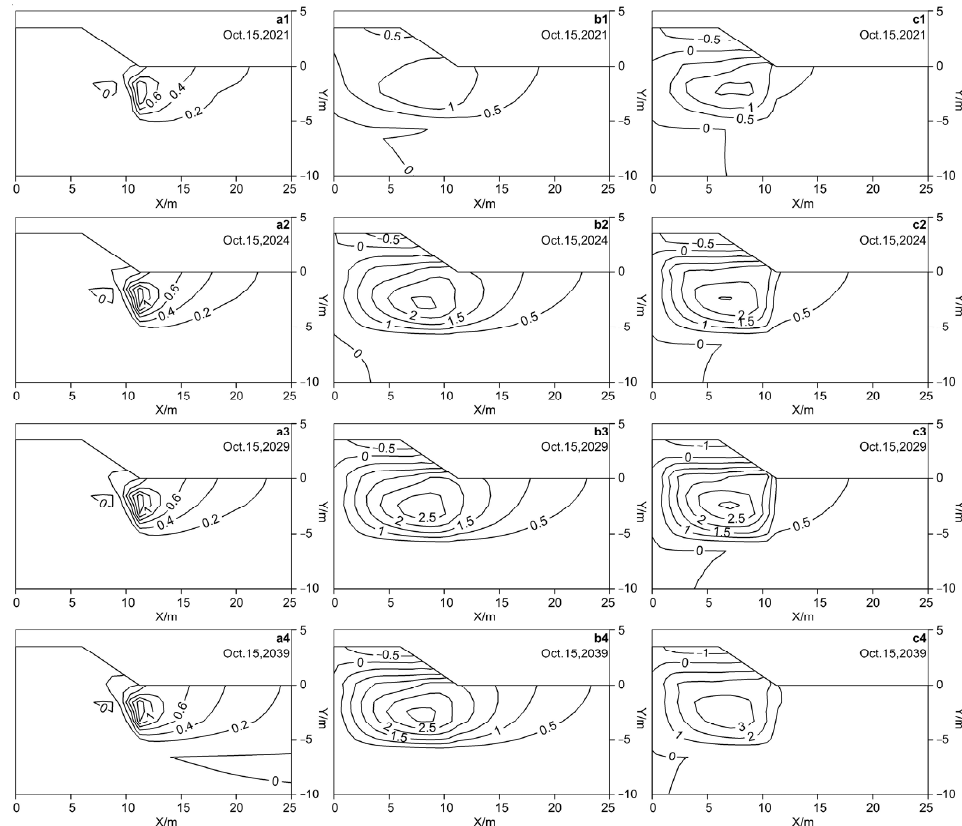
Figure 12. Transverse deformation contour maps of three subgrade structures in different years in warm seasons: ( a1 – a4 ) replacement block–stone subgrade structure, ( b1 – b4 ) replacement breccia subgrade structure, and ( c1 – c4 ) replacement gravel subgrade structure (Unit: cm).